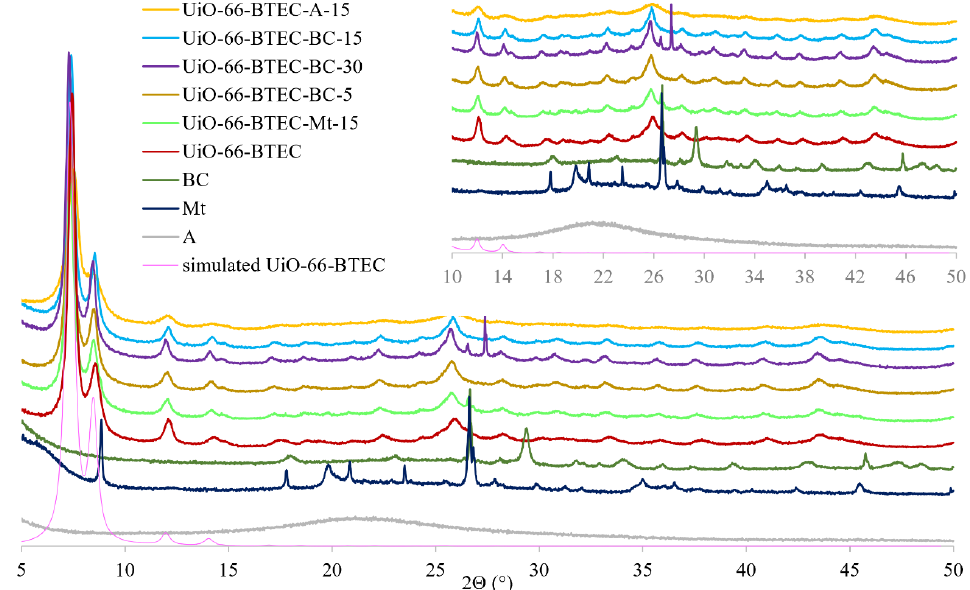
Figure 3. PXRD spectra of aerosil (A), montmorillonite (Mt), biochar (BC), UiO-66-BTEC, UiO-66- BTEC-composites containing aerosil (UiO-66-BTEC-A-15), montmorillonite (UiO-66-BTEC-Mt-15), and PXRD patterns of UiO-66-BTEC-composites containing different amounts of biochar (UiO-66- BTEC-BC-5, UiO-66-BTEC-BC-15, and UiO-66-BTEC-BC-30, respectively). The patterns simulated from the crystal structure data of pure UiO-66-BTEC are shown in pink color. Crystalline lattice parameters were determined for the resulting MOF-composites.